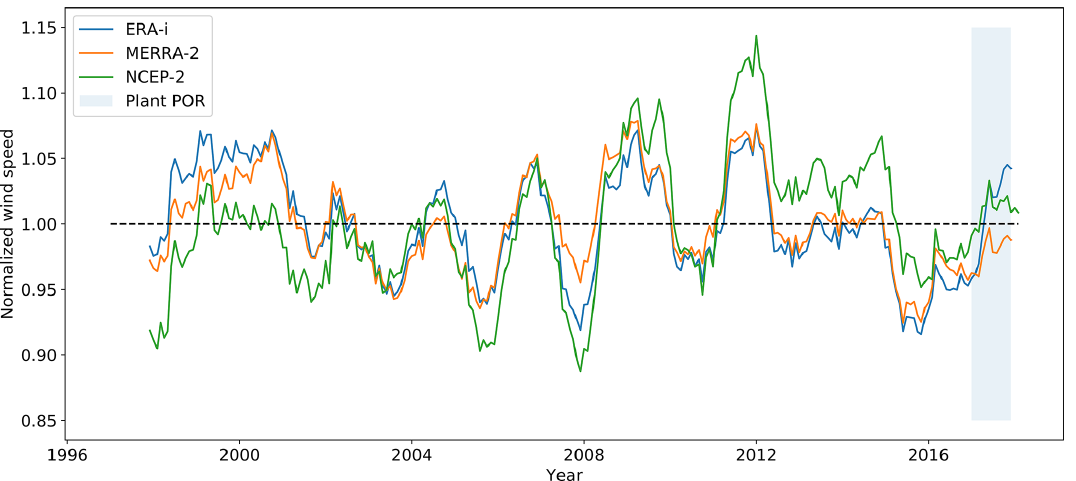
Figure 8. Long-term time series of normalized wind speed for EIA station ID 60502 from the three reanalysis products used in the study. The period of record (POR) for the wind plant is highlighted in light